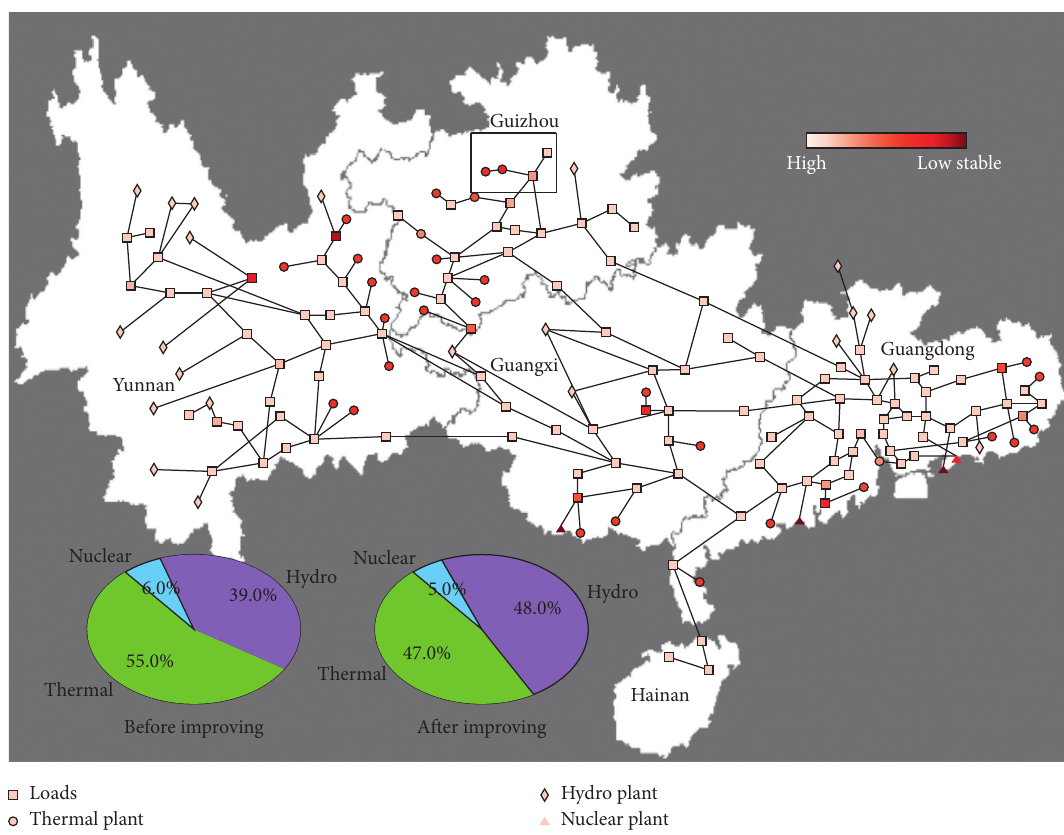
Figure 4: Stability and decarbonization of the CSG. Single-node stability on the China Southern Power Grid (nodes’ type is shown in supplementary table S1, and edges are listed in supplementary table S2). The two pie charts show the percentage of the three kinds of generator plants before and after improving the economic efficiency of hydropower plants by decreasing their c g from 1 to 0.7 and decreasing thermal c g from 1 to 0.9. Parameters are the same as in Figure 3 with τ g � 3 . 0 for thermal plants and τ g � 0 . 2 for